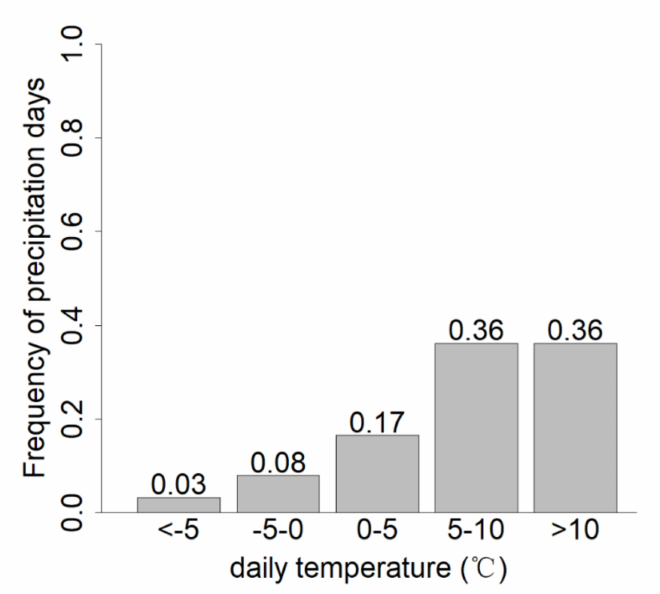
Figure A3. The relationship between daily mean temperature and the distribution of precipitation days.